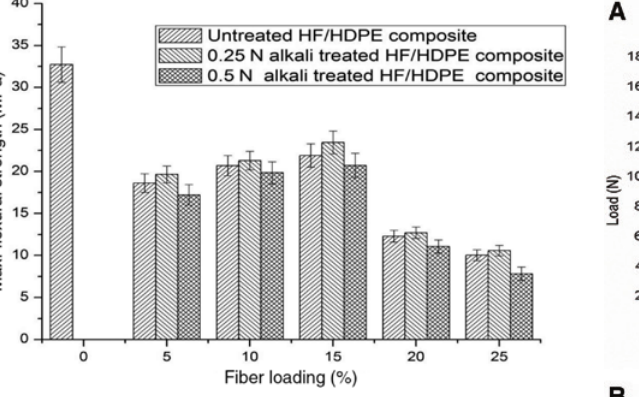
Figure 5: Effect of fiber loading on the flexural strength of HF/HDPE- reinforced composites.